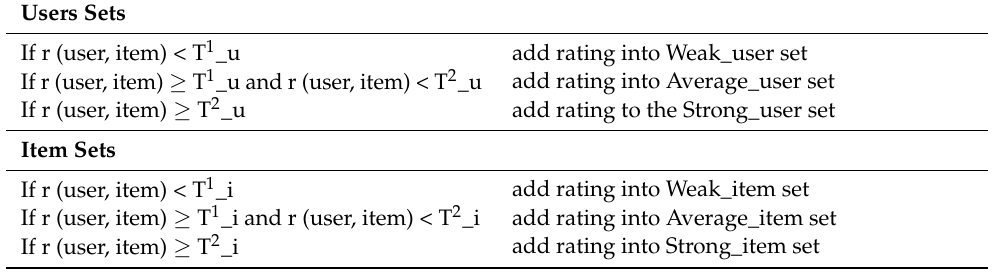
Table 1. Categorized Users and Items into Sets.